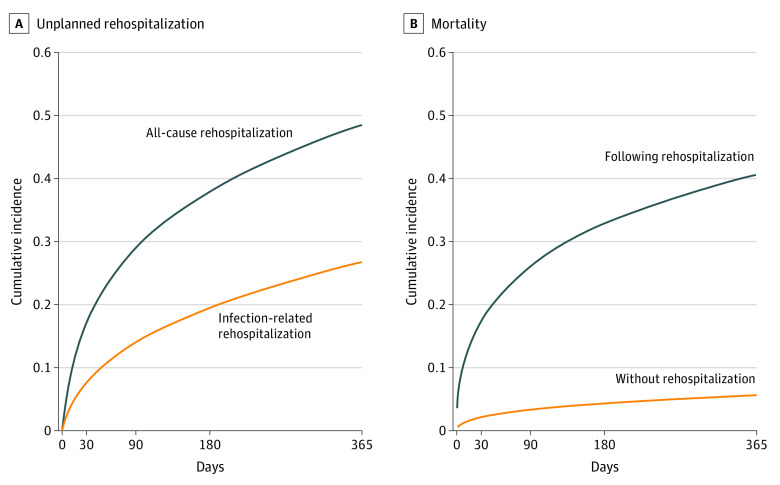
Cumulative Incidence Plots for Unplanned Rehospitalization, Infection-Related Rehospitalization, and Mortality by Rehospitalization StatusA, The cumulative all-cause unplanned rehospitalization rates (blue line) at 30, 90, 180, and 365 days were 16.9%, 28.4%, 36.9%, and 46.9%, respectively. The cumulative infection-related rehospitalization rates (orange line) at 30, 90, 180, and 365 days were 7.7%, 14.1%, 19.4%, and 26.7%, respectively (see eTable 3 in the Supplement for further information). B, The cumulative all-cause mortality rates among patients with 1 or more rehospitalizations (blue line) at 30, 90, 180, and 365 days were 17.4%, 26.2%, 32.8%, and 40.5%, respectively. These are reported using Cox proportional hazards regression models.